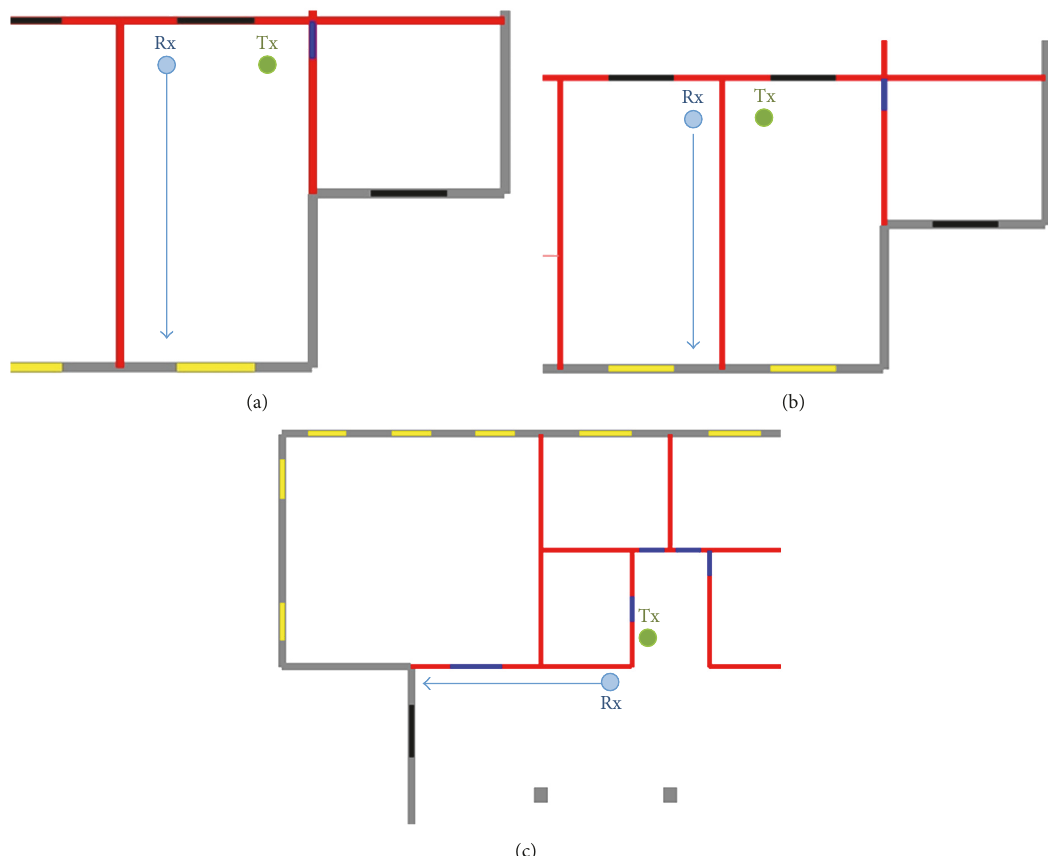
Figure 6: Scenarios: (a) LOS, (b) NLOS, and (c)